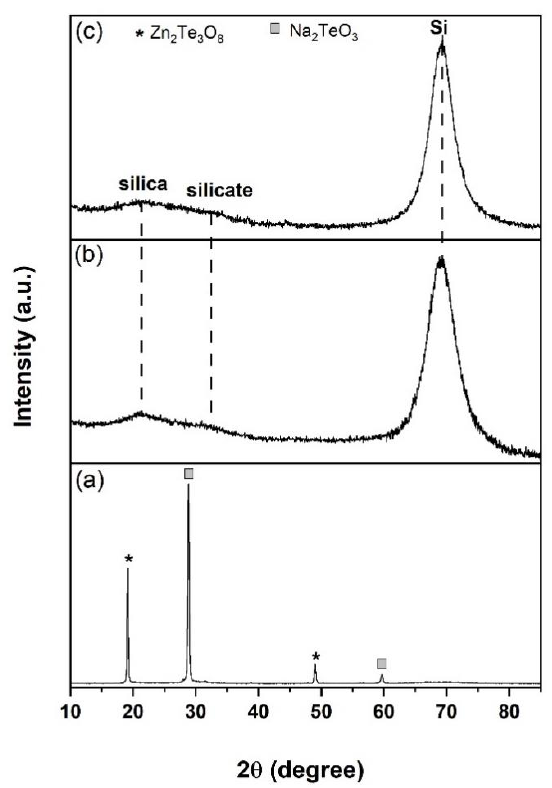
Figure 2. XRD patterns for samples prepared using temperatures of ( a ) 400 °C (B400), ( b ) 570 °C (B570), and ( c ) 700 °C